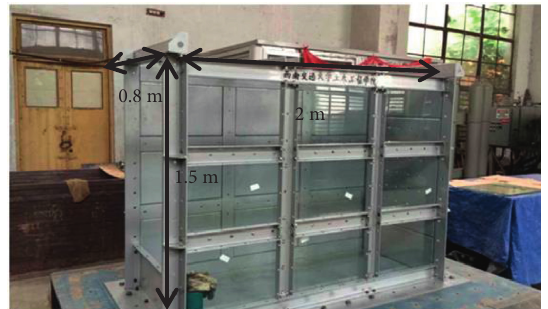
Figure 1: Schematic diagram of the model box.